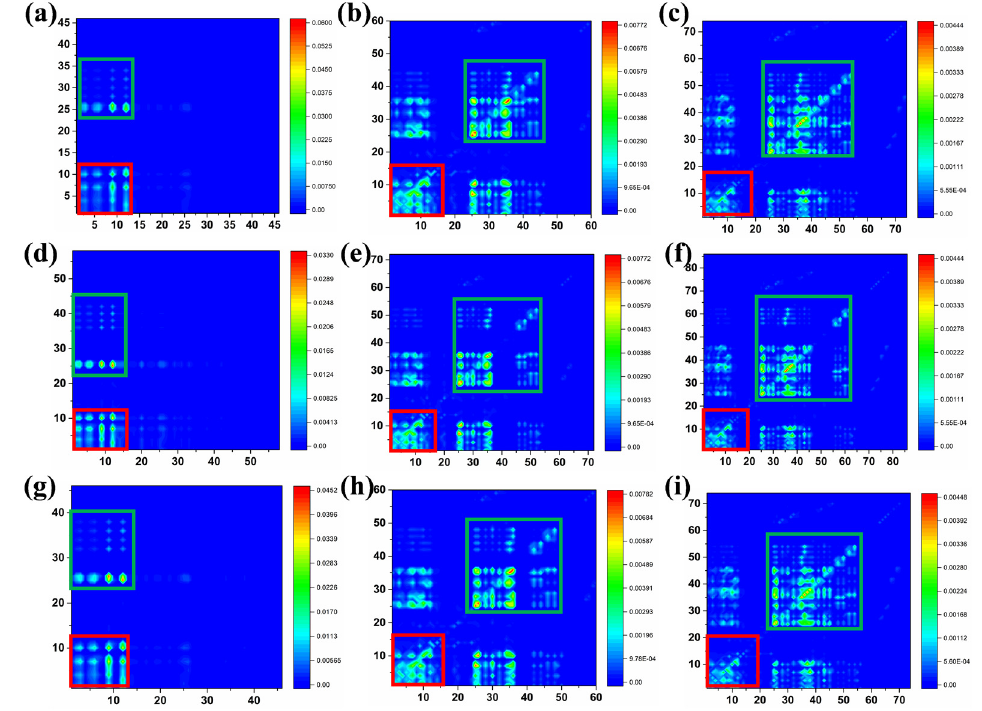
Figure 9. ( a – i ) TDM plots of the compounds